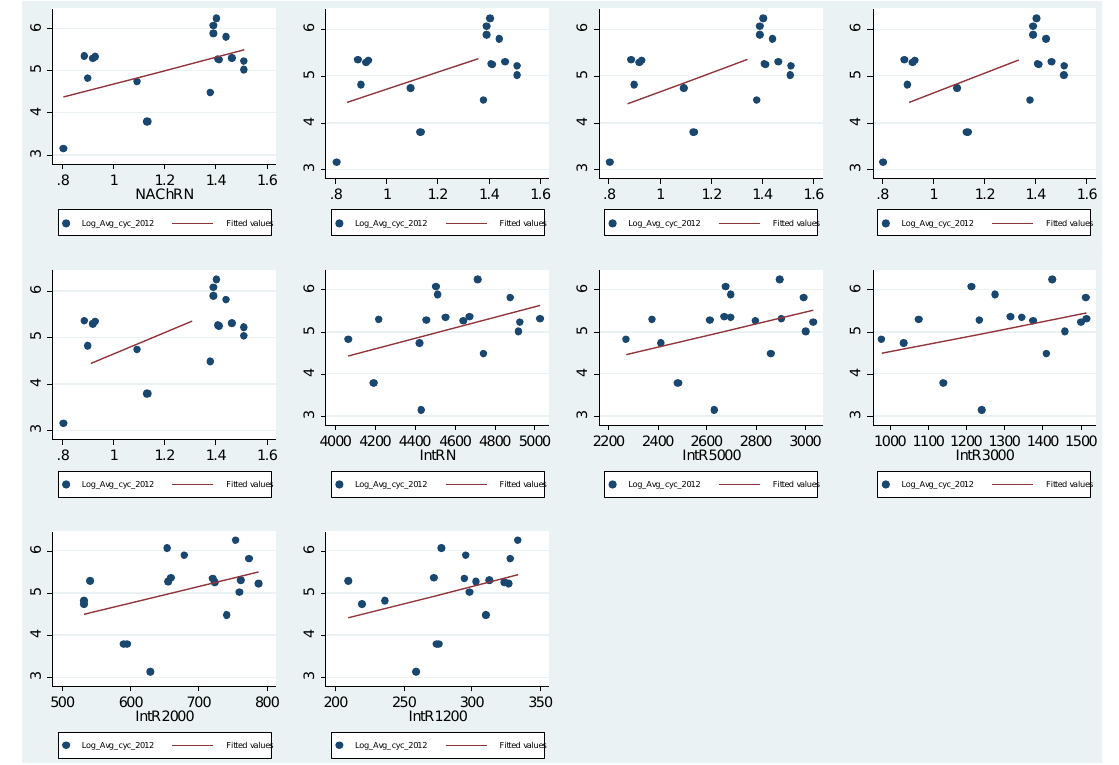
Figure 13. The figure highlights the Log-Log Scatterplots between Log cyclists’ movement 2012 and different radii of Space Syntax measures.